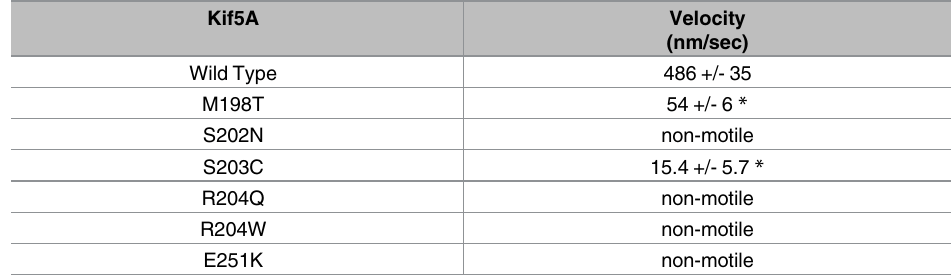
Table 3. Microtubule gliding velocity.